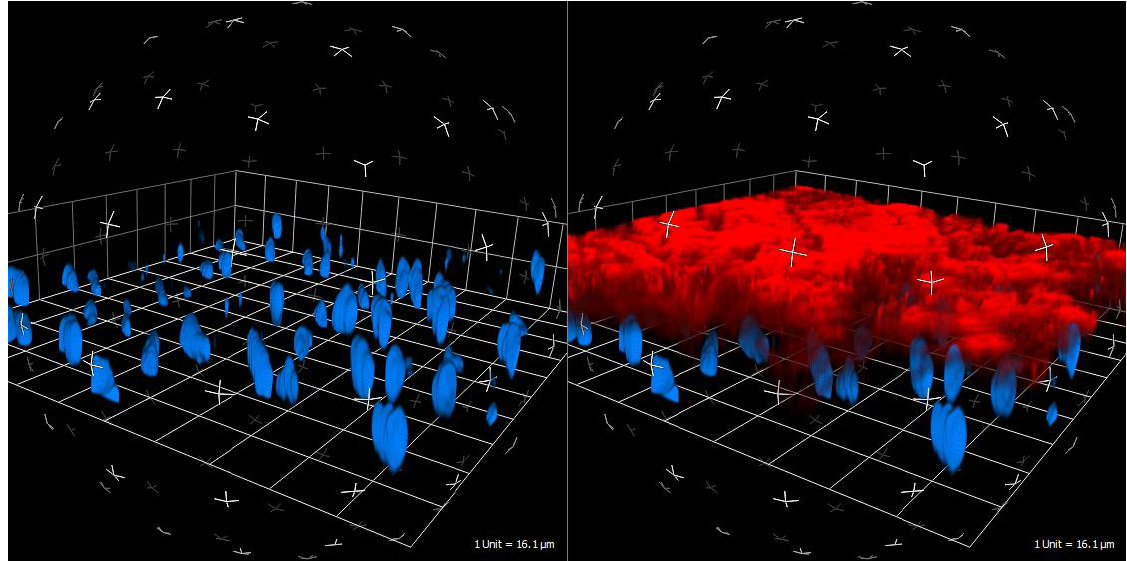
Figure 1. Real time live confocal visualization of the glycocalyx (in red via wheat germ agglutinin) and endothelial cell nuclei (in blue via HOECHST stain). Porcine blood vessel, 40× water immersion objective.